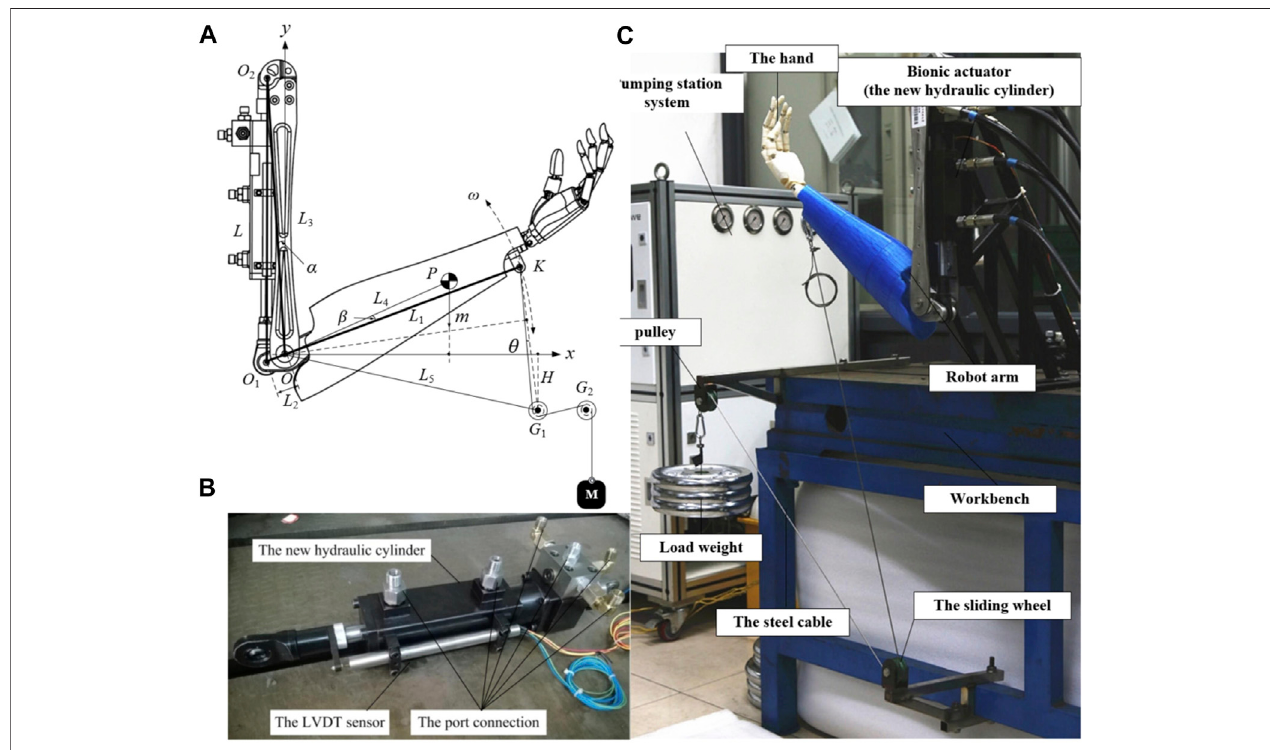
FIGURE 6 | The experiments of the BHA; (A) . The geometry of the human arm; (B) . The real prototype of the proposed actuator; (C) . The experimental system using the proposed